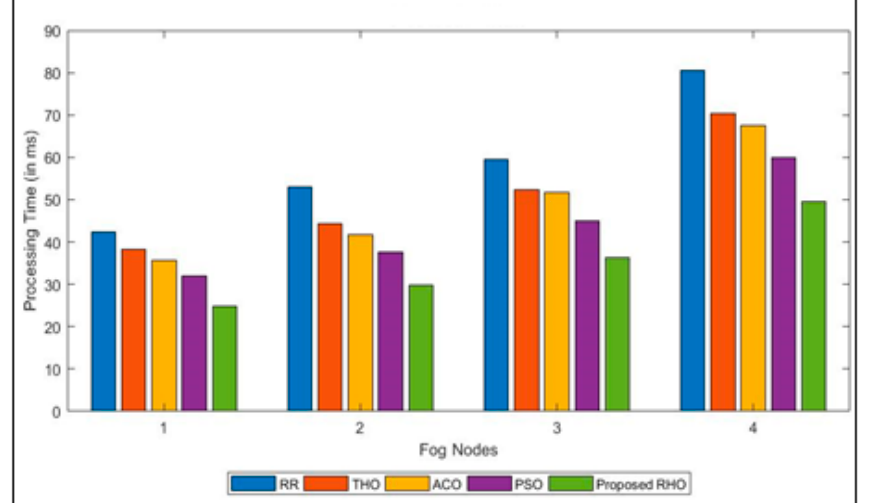
Figure 5. Processing Time for different algorithms for different Fog Nodes.